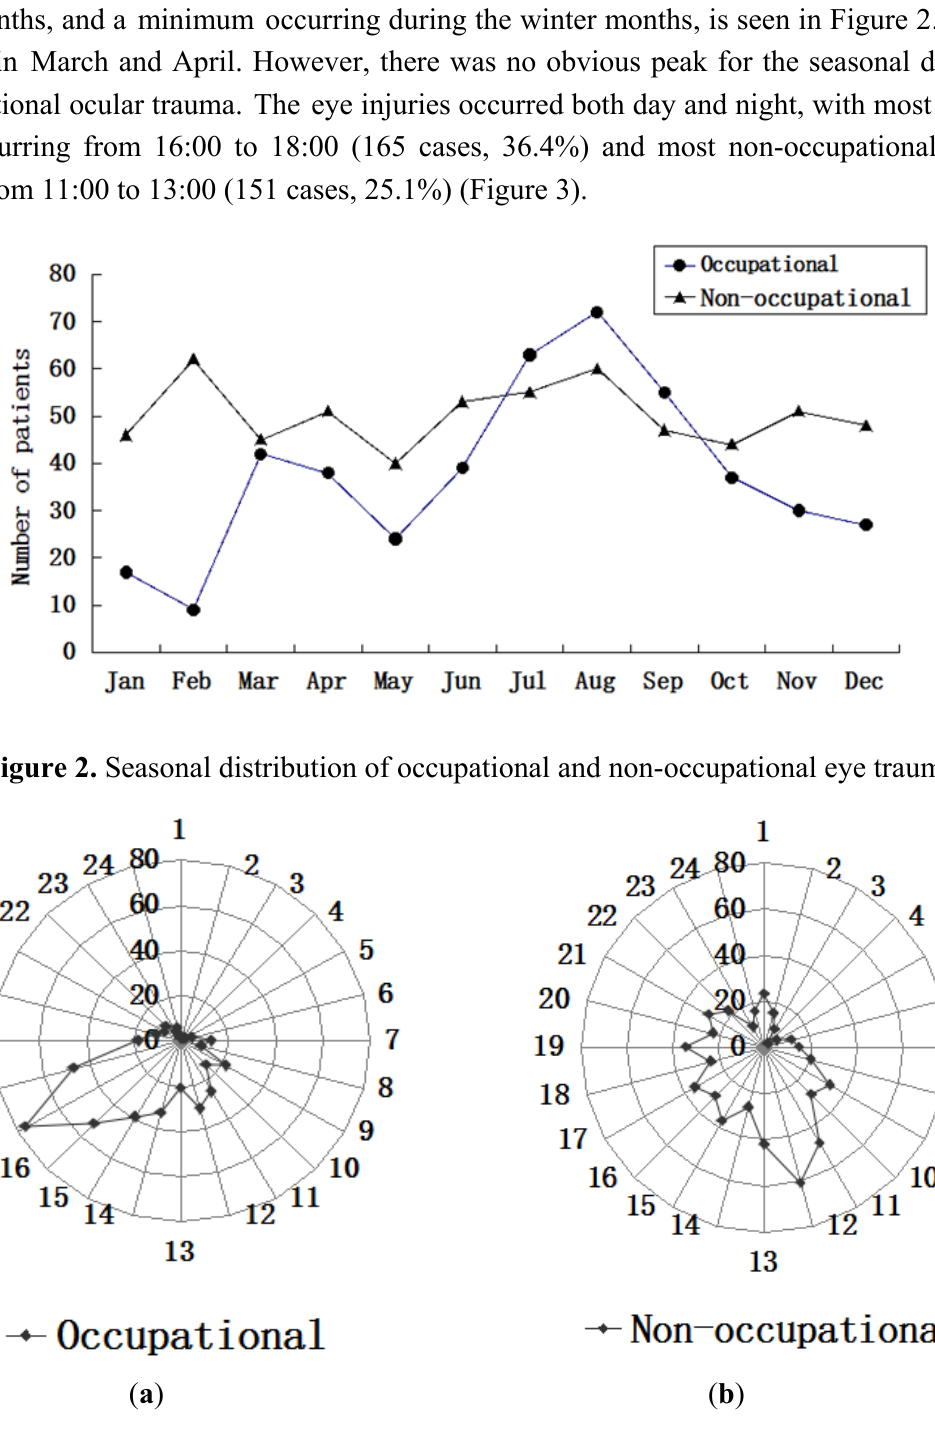
Figure 3. ( a , b ) Incidence times of occupational and non-occupational eye trauma over a one-day